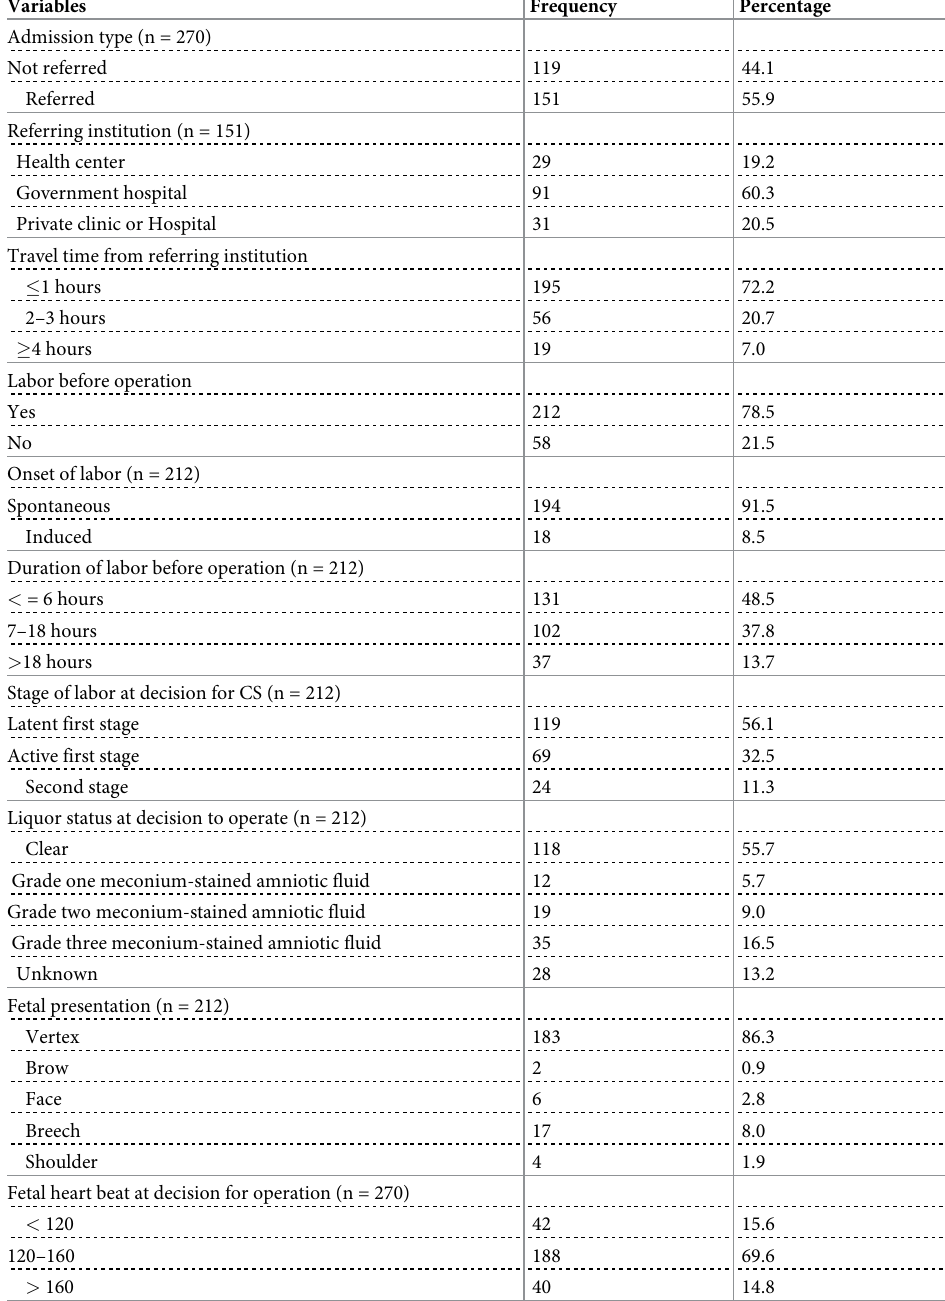
Table 3. Admission and preoperative characteristics of respondents in Hawassa University comprehensive spe- cialized hospital, Southern Ethiopia,